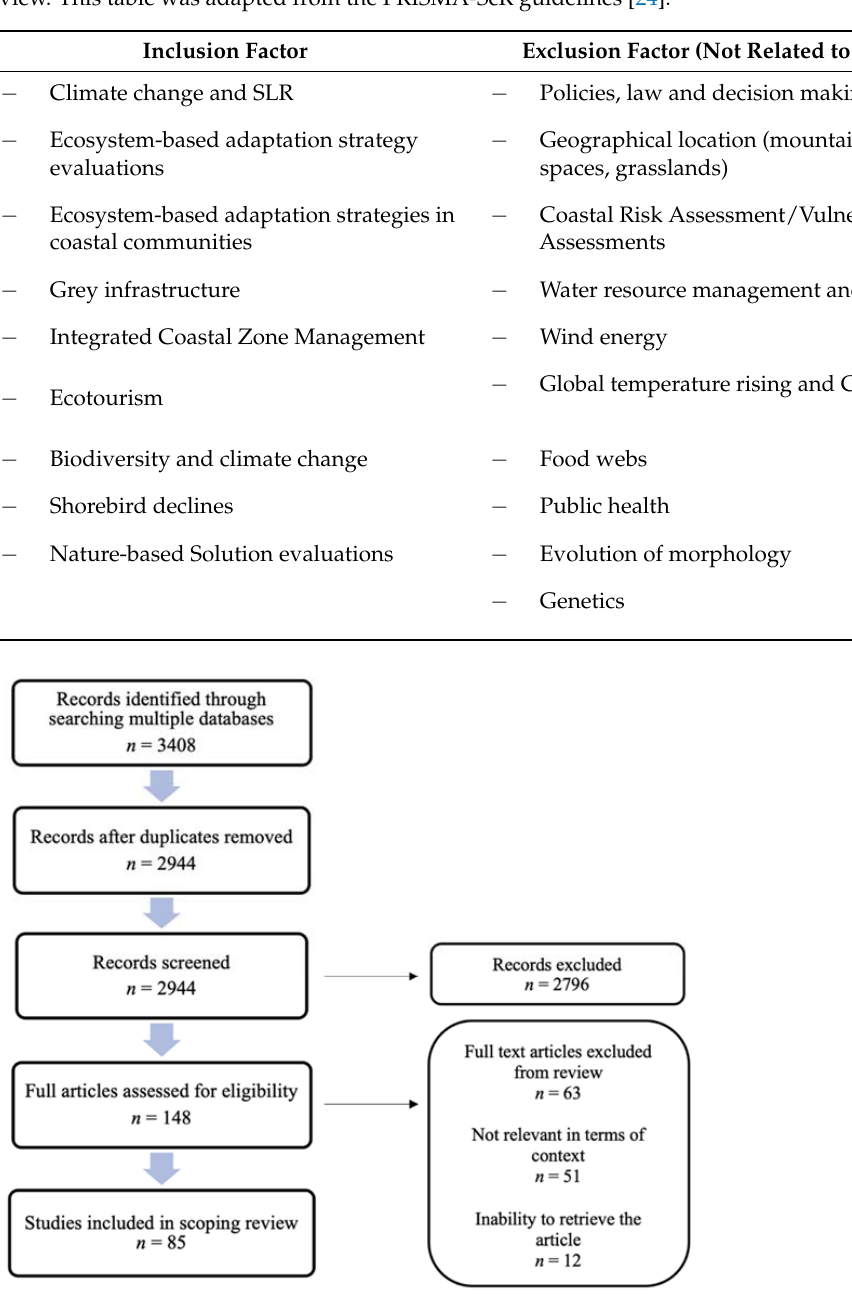
Figure 2. Flow diagram illustrating the selection literature sources used in the scoping review process. This flow diagram was adapted from the PRISMA ‐ ScR guidelines [24] .